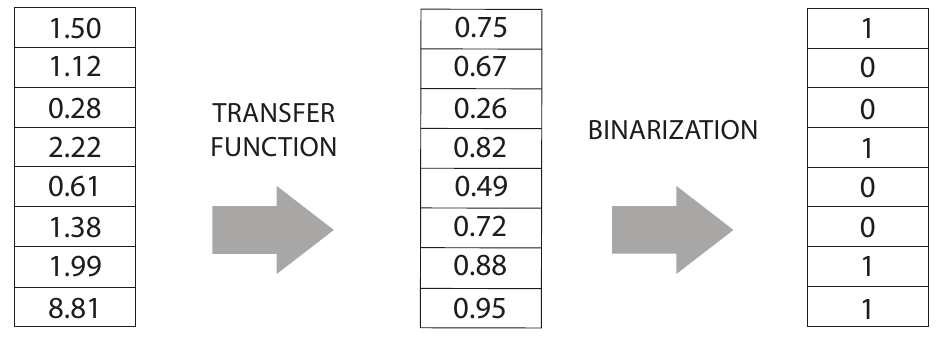
Figure 1. Two-step Binarization